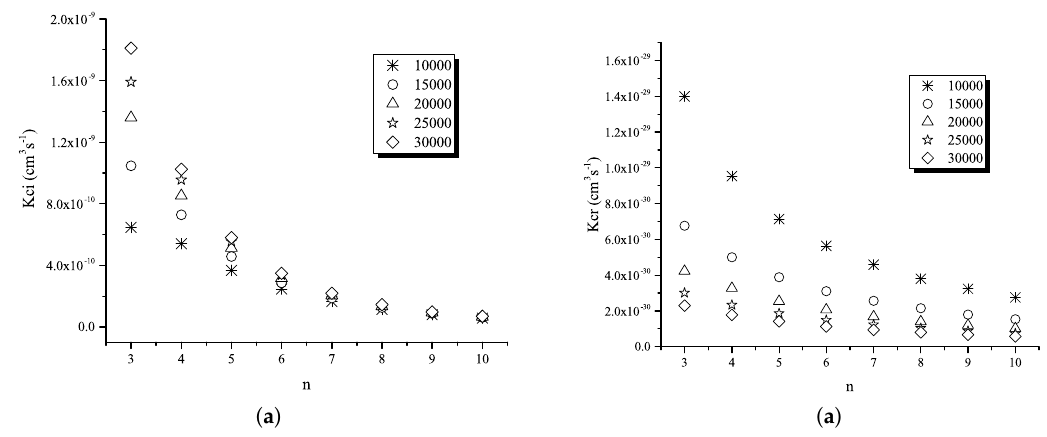
Figure 6. ( a ) total chemi-ionization rate coefficients Kci ( n ; T ; He ) with 10,000K ≤ T ≤ 30,000 K and for principal quantum numbers n = 3–10; ( b ) same as in (a) but for the inverse recombination coefficients Kr ( n ; T ; He ) (data taken from [36]).